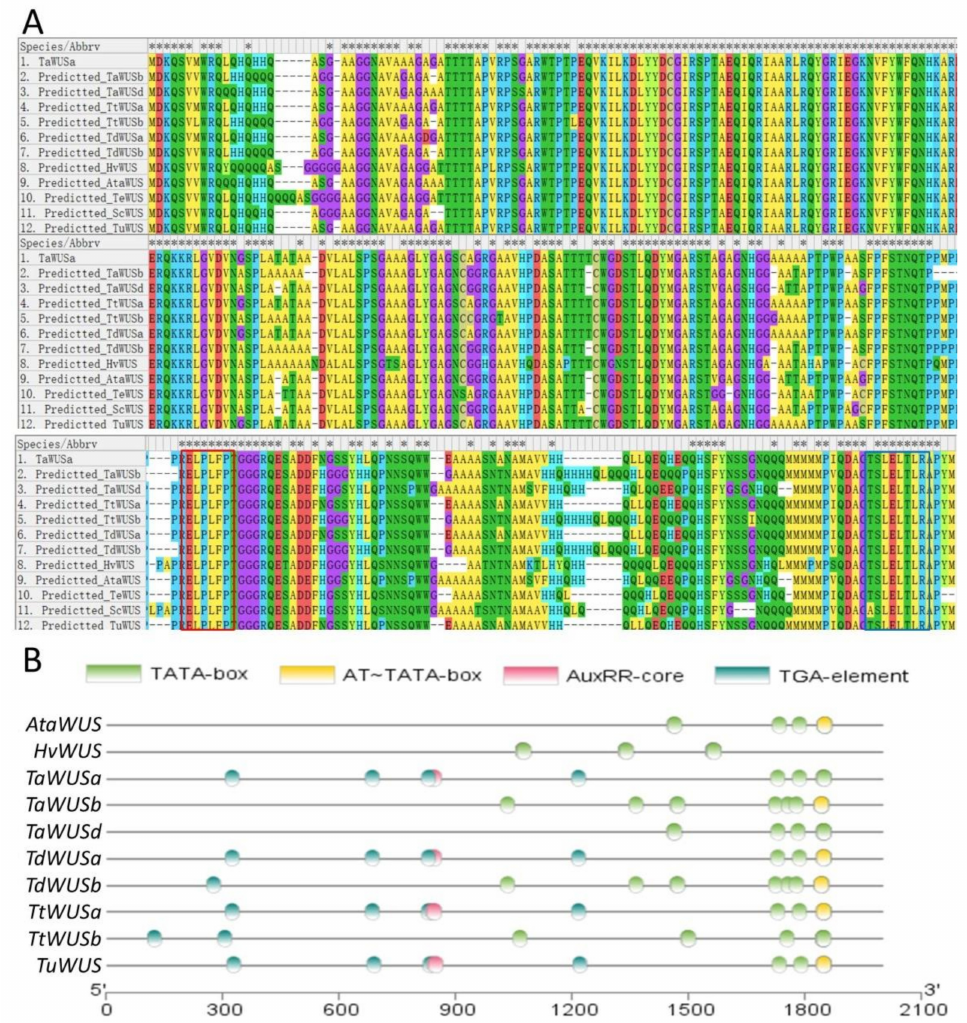
Figure 1. Multiple-sequence alignment and element prediction of the promoters among TaWUS and other predicted WUS genes from nine Triticeae species. ( A ) Multiple sequence alignment among TaWUS and other predicted WUS proteins. Alignment of protein sequences was conducted by ClustalW algorithm using MEGA X. The position of conserved WUS-box motif was shown in red box, and the position of EAR domain was shown in blue box. The conserved amino acid sites were marked with asterisk (*). ( B ) Element prediction of the promoter regions of TaWUS and other predicted WUS genes in six Triticeae species. TATA-BOX elements and their positions in the promoters were displayed in green oval, AT~TATA-BOX elements and their positions in yellow oval, cis-acting regulatory elements involved in auxin responsiveness AuxRR-core and their positions in red oval, and auxin-responsive TGA-elements and their positions in blue